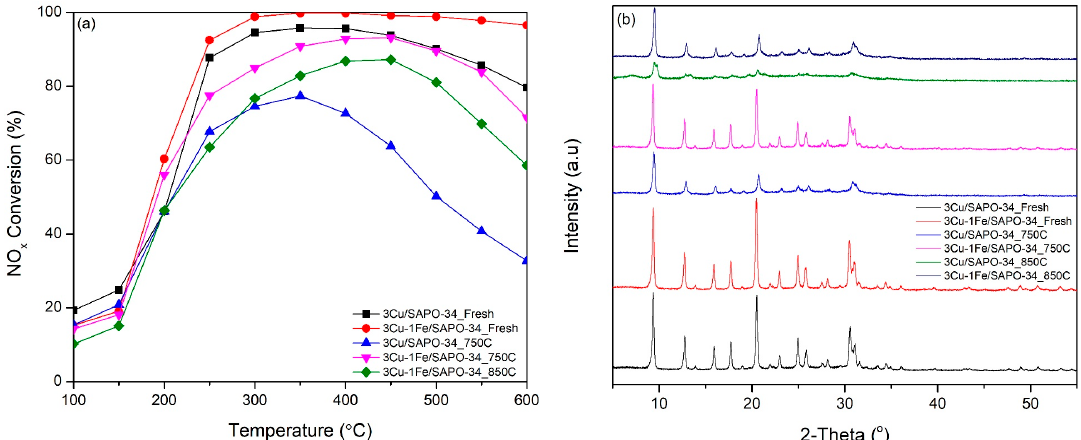
Figure 10. ( a ) NO x conversion of Cu/SAPO-34 and Cu-Fe/SAPO-34 after hydrothermal aging and ( b ) XRD patterns of fresh and hydrothermal aging catalysts.